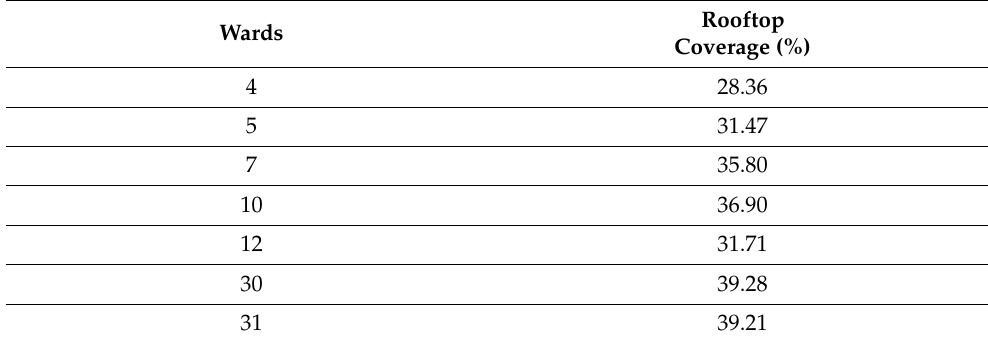
Figure 8. Rooftop Coverage in Kathmandu Metropolitan City’s wards that should be highly priori- tized for Urban Green Space establishment. Table 2. Rooftop Coverage in Kathmandu Metropolitan City’s wards that should be very highly prioritized for Urban Green Space establishment .